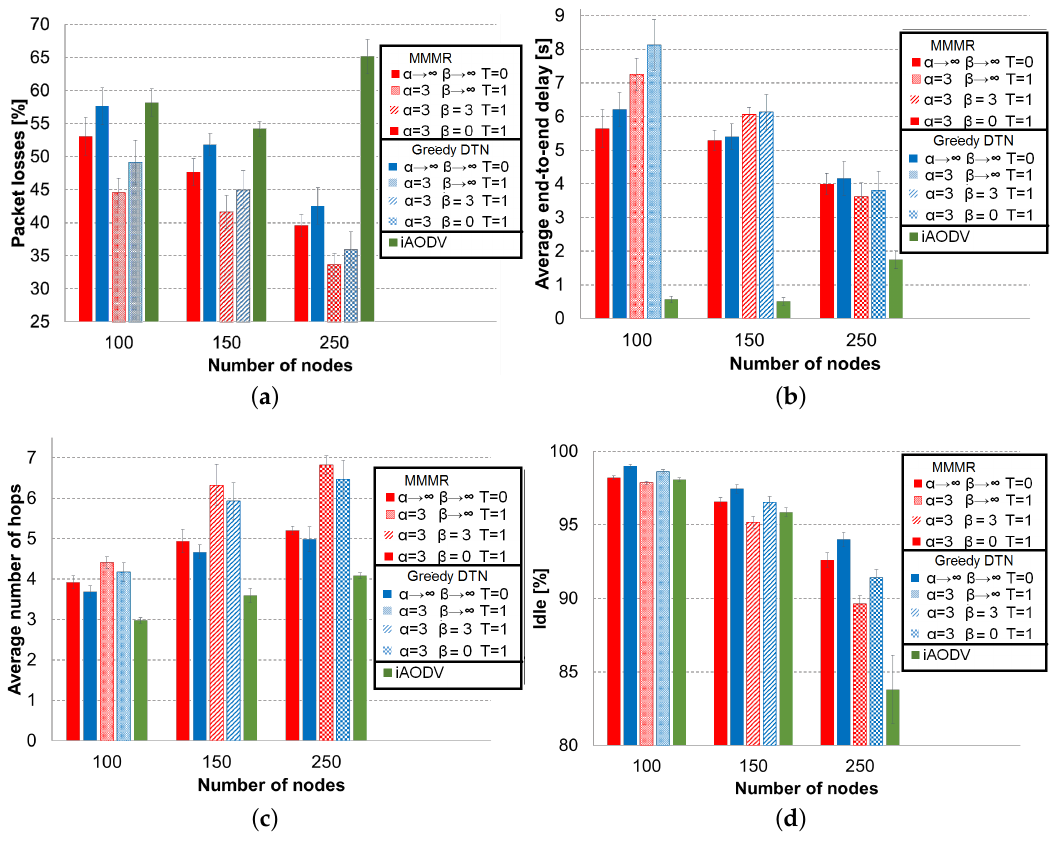
Figure 7. Performance comparison of the best GHR configurations using MMMR and greedy-DTN as the scoring algorithms and iAODV . ( a ) Percentage of packet losses; ( b ) average end-to-end packet delay; ( c ) average number of hops; ( d ) percentage of idle